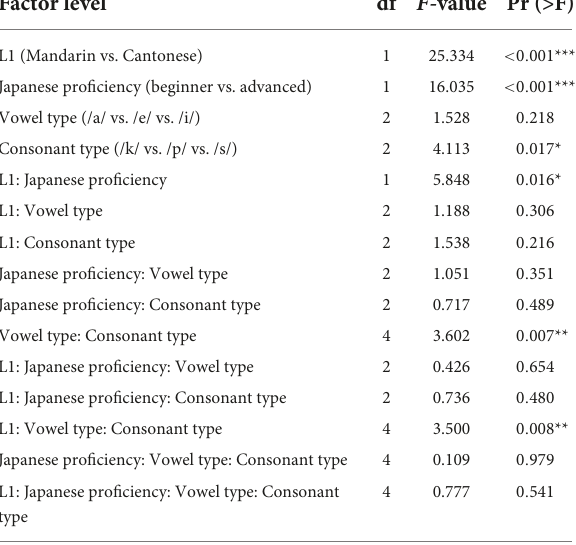
TABLE 3 The ANOVA summary: ‘dPrime’ ∼ L1 * Japanese proficiency * vowel types * consonant types. Factor level df F -value Pr (>F) L1 (Mandarin vs.